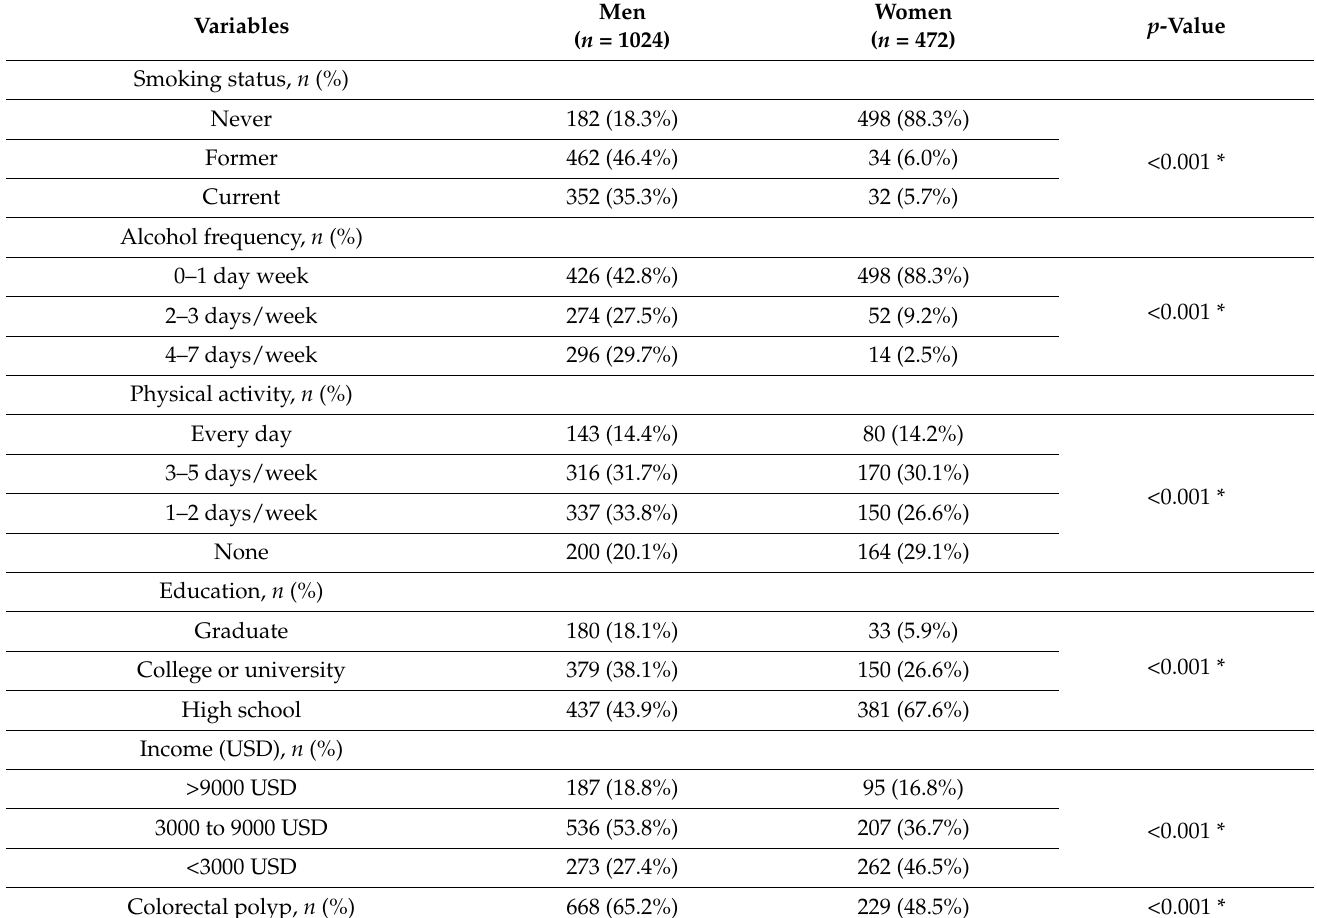
Table 2 summarizes the results of the chi-square test. The proportion of colorectal